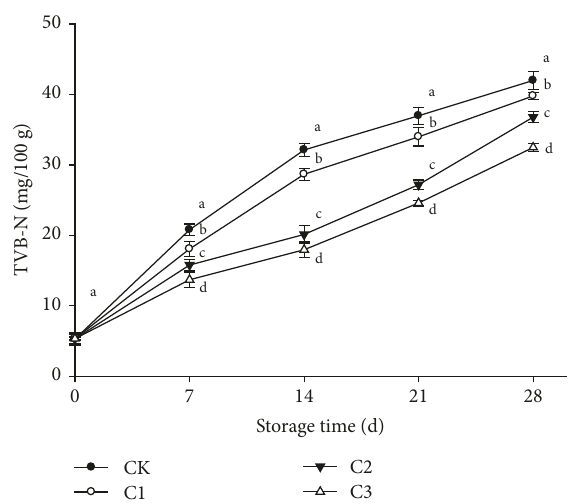
Figure 5: Changes in met-Mb content of beefsteaks with different treatments during storage. CK, the group of beefsteaks without pretreatments; C1, the group of beefsteaks pretreated with 100% CO for 1.5 h; C2, group of beefsteaks pretreated with 100% CO for 1.5 h and soaked in 50 mg/LClO 2 ; C3, group of beefsteaks pretreated with 100%CO for 1.5 h and soaked in 50 mg/L ClO 2 for 10 min and sprayed with 30 g/L lactic acid. Data were represented with mean values ± Standard Error; sometimes the bars were too small to see. Different letters mean significant difference of samples with different treatments on the same storage days ( 𝑃 < 0.05 ). Three separate steaks of each treatment were measured; three repetitions were performed for each treatment. 𝑛 = 9